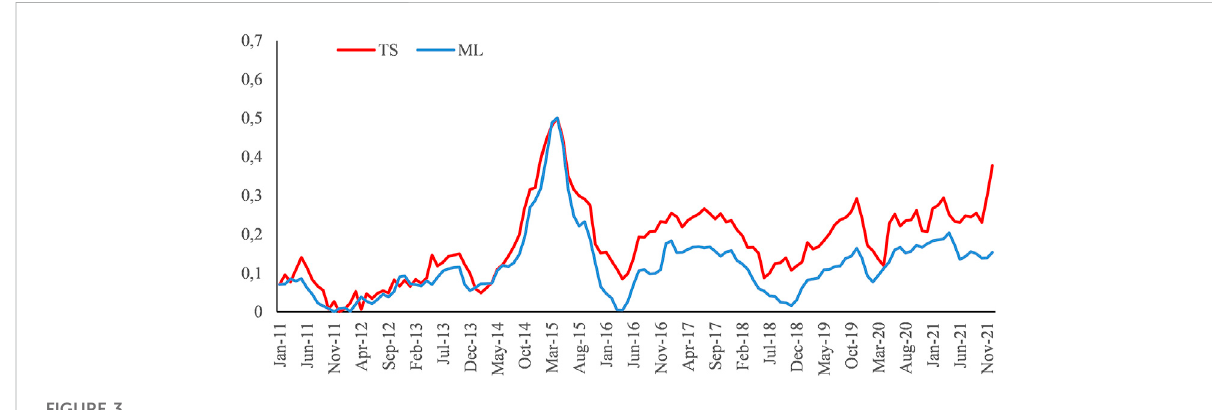
FIGURE 3 FSI trends. Note: TS represents the calculation result of the Two-step estimation method and ML represents the calculation result of the QML- EM estimation